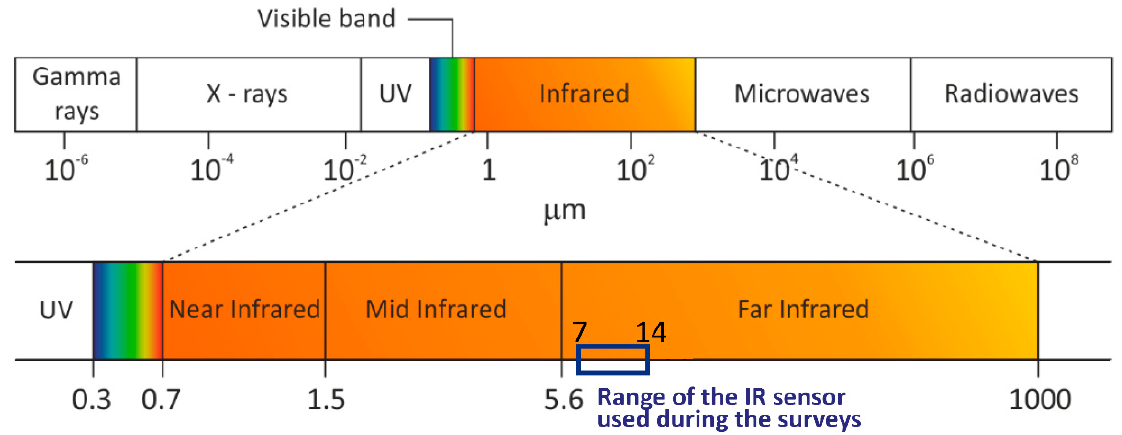
Figure 1. Schematic representation of the InfraRed spectrum (modified after [7]).